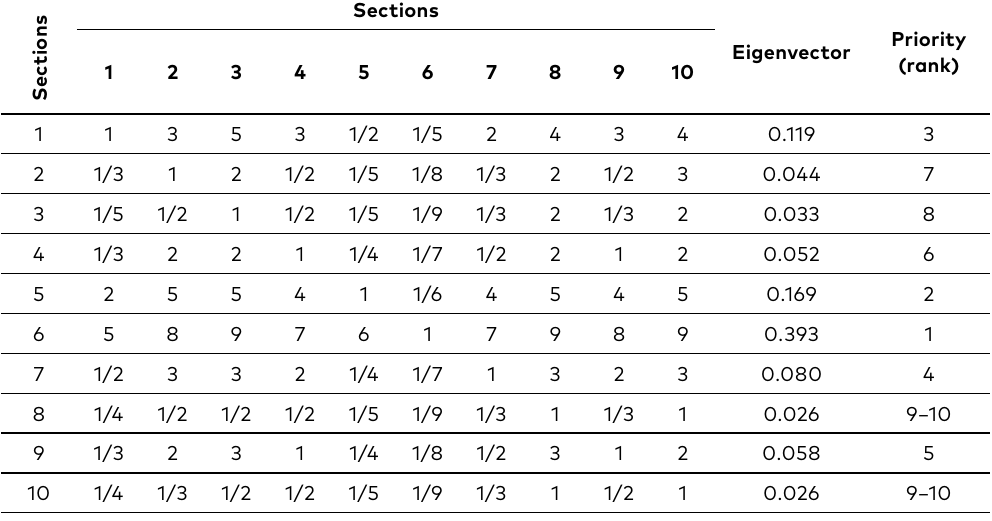
Table 8. Pairwise comparison of the accident sections concerning the total number of participated people in accident section (CR3)